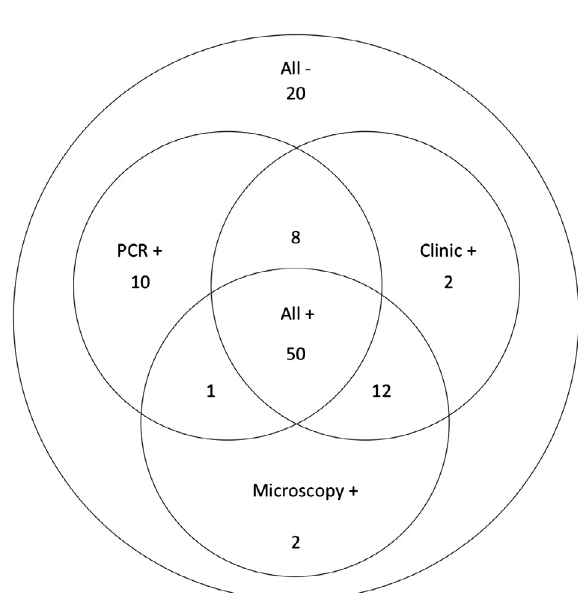
Figure 6. Venn diagram of results. Comparison of the results for the three diagnostic